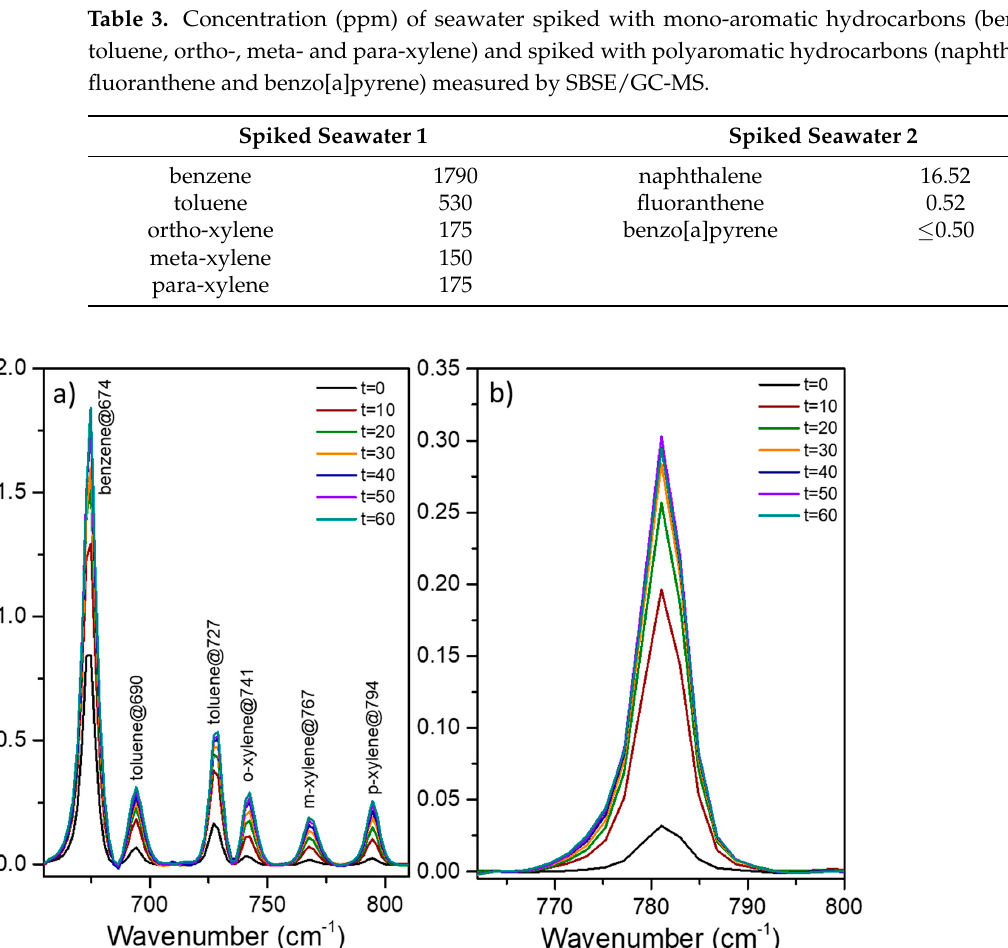
Figure 10. MIR-ATR absorption spectra of seawater ( a ) spiked with benzene (1790 ppm), toluene (530 ppm), ortho- (175 ppm), meta-, and para-xylenes (150/175 ppm) (BTXs) and ( b ) spiked with naphthalene, fluoranthene, and benzo[a]pyrene in the range of 17–18 ppm for different enrichment times (from 0 to 90 min for Seawater Sample 1 and from 0 to 60 min for Seawater Sample 2) . Table 3. Concentration (ppm) of seawater spiked with mono-aromatic hydrocarbons (benzene, toluene, ortho-, meta- and para-xylene) and spiked with polyaromatic hydrocarbons (naphthalene, fluoranthene and benzo[a]pyrene) measured by SBSE/GC-MS. Spiked Seawater 1 Spiked Seawater 2 benzene